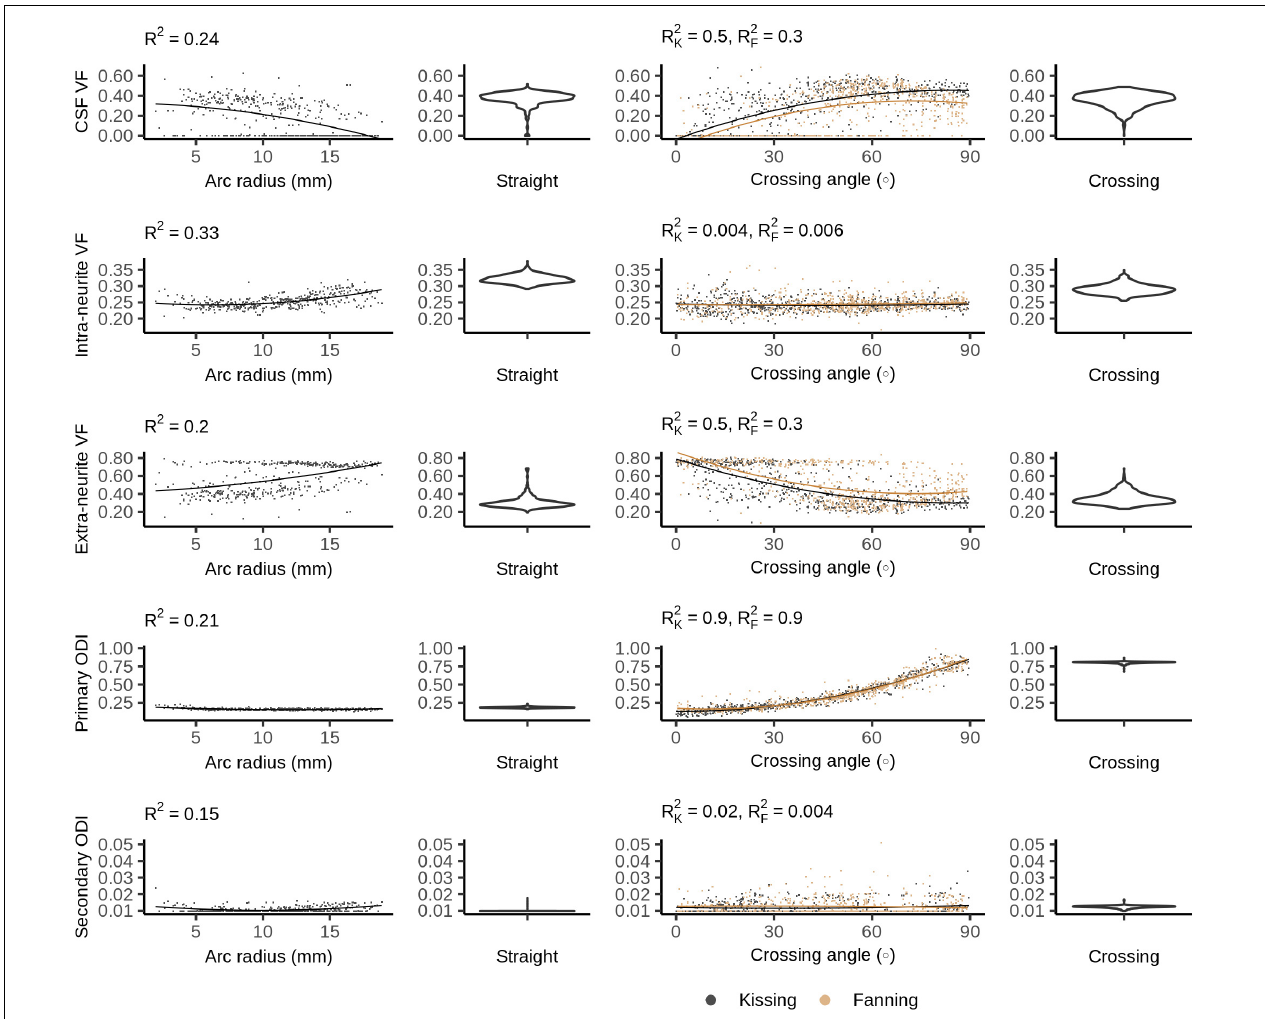
FIGURE 8 | Bingham-Neurite orientation density and dispersion imaging (NODDI) metrics vs. orientation dispersion metrics in each of the four phantoms. The violin plots shown for the straight and crossing phantoms depict the probability density of values observed in the voxels of those phantoms.